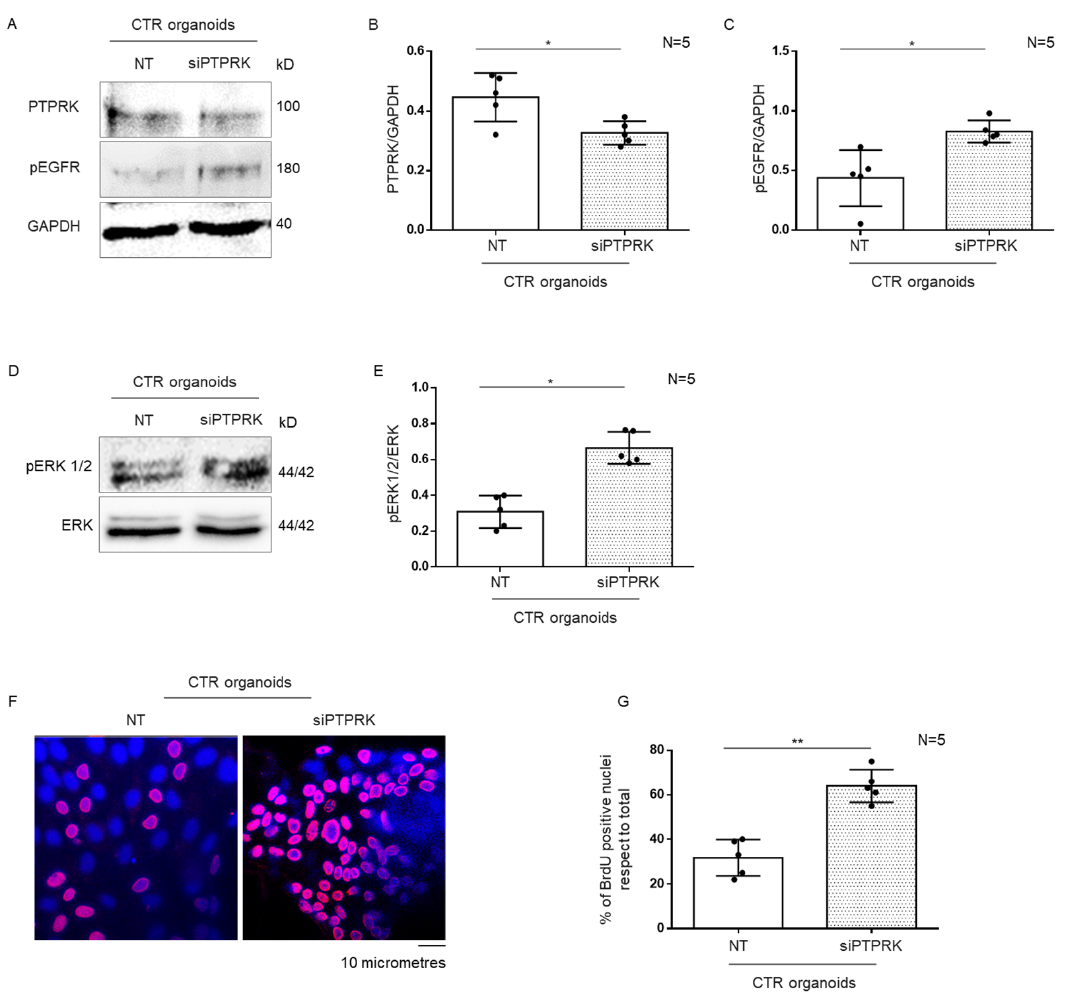
Figure 4. Silencing PTPRK in CTR organoids induced increase inpEGFR, pERK and proliferation . ( A ). Western blot analysis of total protein lysates of CTR organoids transfected and not with silencing PTPRK (siPTPRK). The membrane was blotted with antibodies against PTPRK, pEGFR and GAPDH as loading control. ( B , C ).Densitometric analysis of the PTPRK/GAPDH and pERK/GAPDH bands. Columns represent the mean and bars the standard deviation. Student’s t test: * = p < 0.05. ( D ). Upper lines were blotted with an antibody against pERK. Bottom lines were blotted with anti-ERK antibodies as loading control. ( E ). Densitometric analysis of the pERK/ERK bands. Columns represent the mean and bars the standard deviation. Student’s t test: * = p < 0.05. ( F ). Immunofluorescence images of anti-BrdU staining on intestinal organoids from CTR. Red nu- clei are positive for BrdU staining. ( G ). Statistical analysis of the percentage of BrdU positive nuclei in intestinal organoids from CTR. Columns represent the mean and bars the standard deviation.